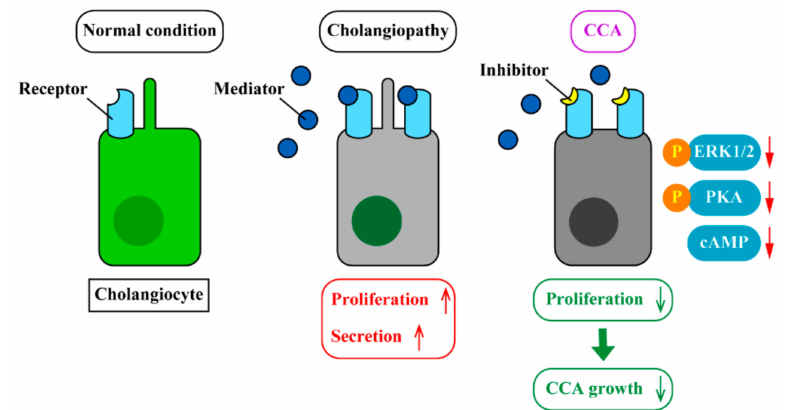
Figure 1. Strategy for the development of novel CCA therapies. Cholangiocytes express various receptors that interact with neuroendocrine mediators. During cholangiopathies such as primary sclerosingcholangitis(PSC),expressionlevelsofmediatorsandreceptorsareupregulated, whichinduces cholangiocyte proliferation and secretion leading to ductular reaction and liver fibrosis. This alteration of cholangiocyte functions may cause CCA development. Upregulation of these mediators and receptors is also observed in CCA tumors. Inhibition of the mediator / receptor axis using antagonists for receptors decreases cAMP levels as well as activation of PKA / ERK1 / 2 pathways, which attenuates CCA progression and migration. However, e ff ects of mediators may di ff er between cancerous and non-cancerous cholangiocytes depending on the mediators. In addition, cholangiocytes may express multiple subtypes of receptors for the specific mediators, and functions of receptors may di ff er between di ff erent subtypes. Further studies are required to develop a novel drug to target the specific mediator or receptor subtype for the regulations of CCA cell